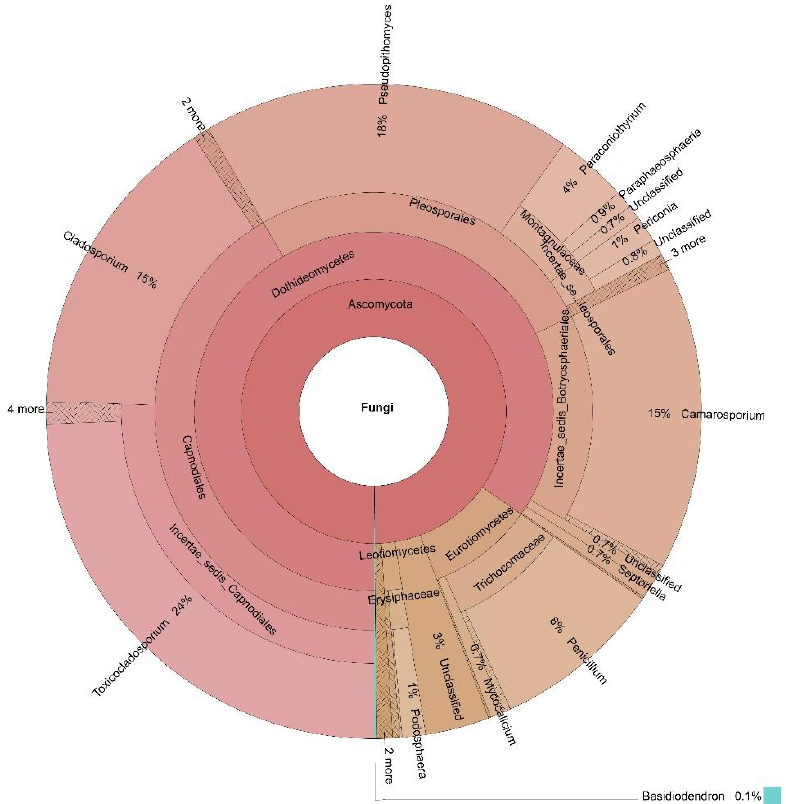
Figure 4 . Krona display of the fungal composition of the samples from Sofia.